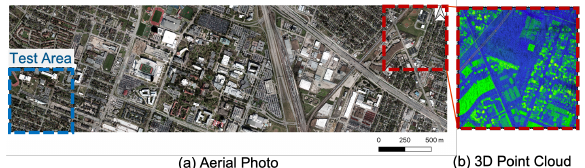
Figure 3. Experimental dataset used in this paper. We used pairs of aerial photo and point clouds observed by airborne LiDAR, published in 2018 IEEE GRSS Data Fusion Contest (Saurabh Prasad, 2020).